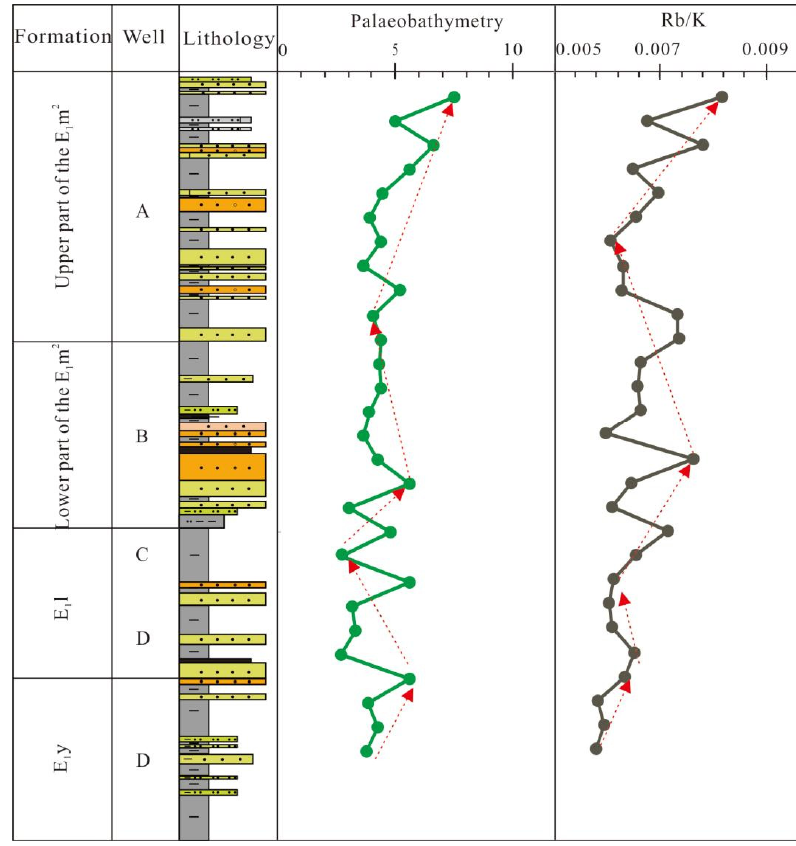
Figure 13. The evolution profile of the paleobathymetrics in the West Lishui